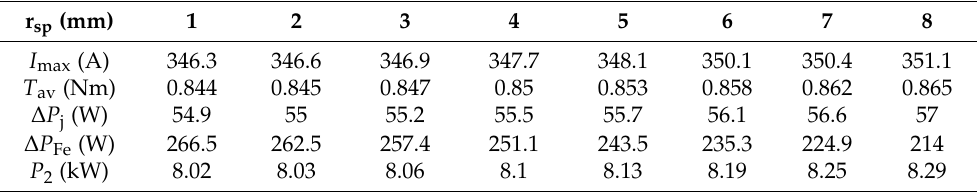
Table 7. Results of the analysis of the rounding at the junction of